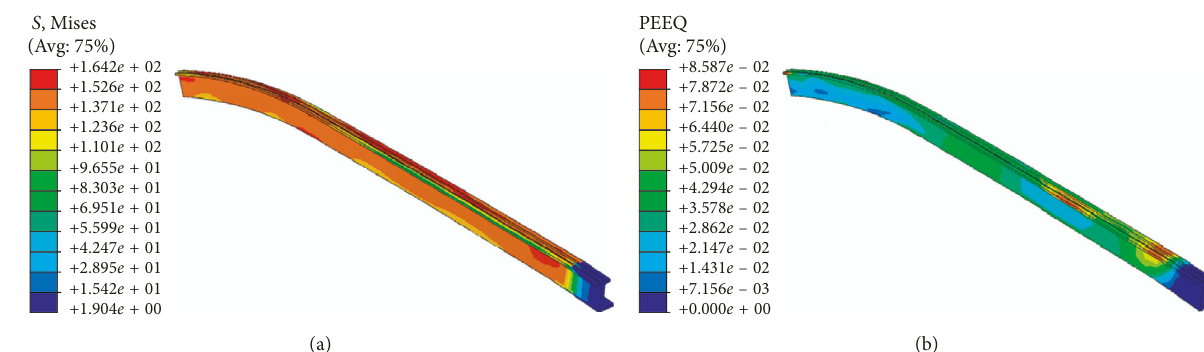
Figure 5: Stress-strain chart of 3D stretch bending (combination A